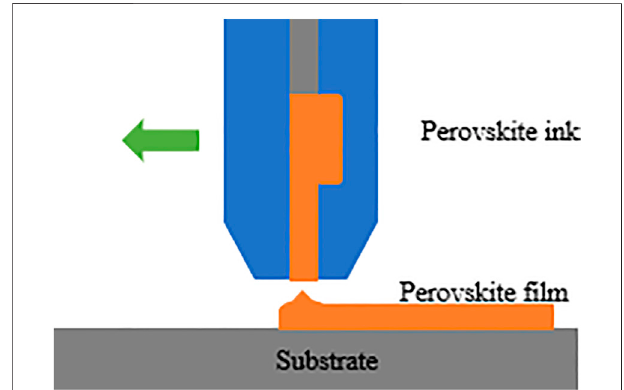
FIGURE 8 | Schematic of perovskite fi lm fabrication through slot-die